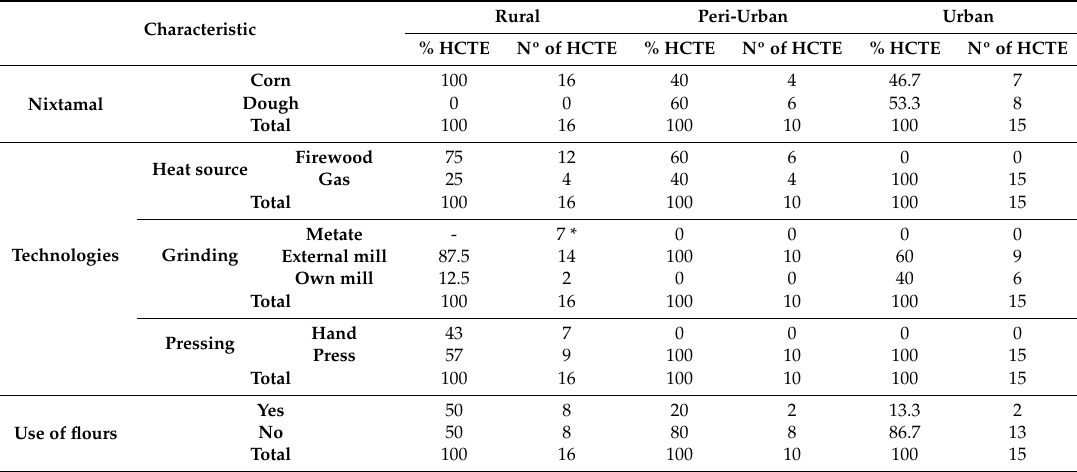
Table 3. Main features in HCT elaboration